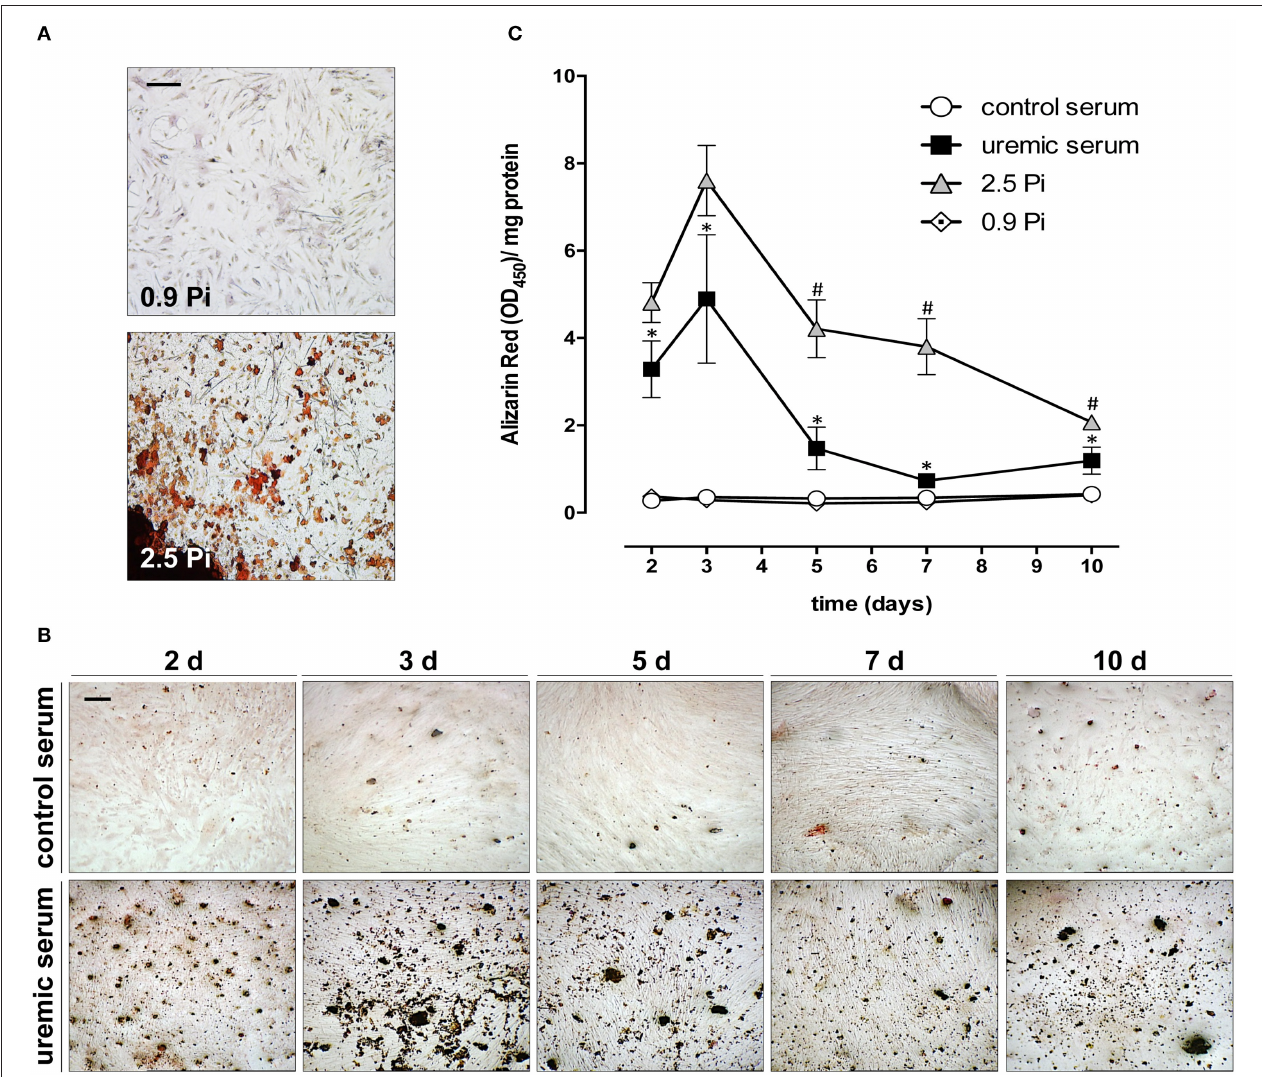
FIGURE 1 | Quantification and time-course of calcification in HASMCs treated with high phosphate or serum from uremic patients. Cells were incubated for the indicated time in DMEM with the standard amount of inorganic phosphate (0.9 Pi), increased amount of Pi and Ca 2 + (2.5 Pi), or in DMEM supplemented with 20% control or uremic serum. (A) Representative micrographs of HASMCs cultured in DMEM with 0.9 Pi or increased amount of inorganic phosphate and calcium (2.5 Pi) and stained with Alizarin red. Bar, 150 µ m. (B) Representative micrographs of HASMCs cultured in DMEM supplemented with control or uremic serum for the indicated amount of times (values in days) and stained with Alizarin red. Bar, 110 µ m . (C) Quantitative analysis of calcium phosphate deposition by Alizarin Red staining; each point represents the average ± SE absorbance at 450nm for the indicated day of treatment (three independent experiments, with 4 replicas per condition in each experiment). Values were compared using a one-way ANOVA followed by Tukey’s multiple comparisons test. *Significant vs. control serum; # significant vs. uremic serum.